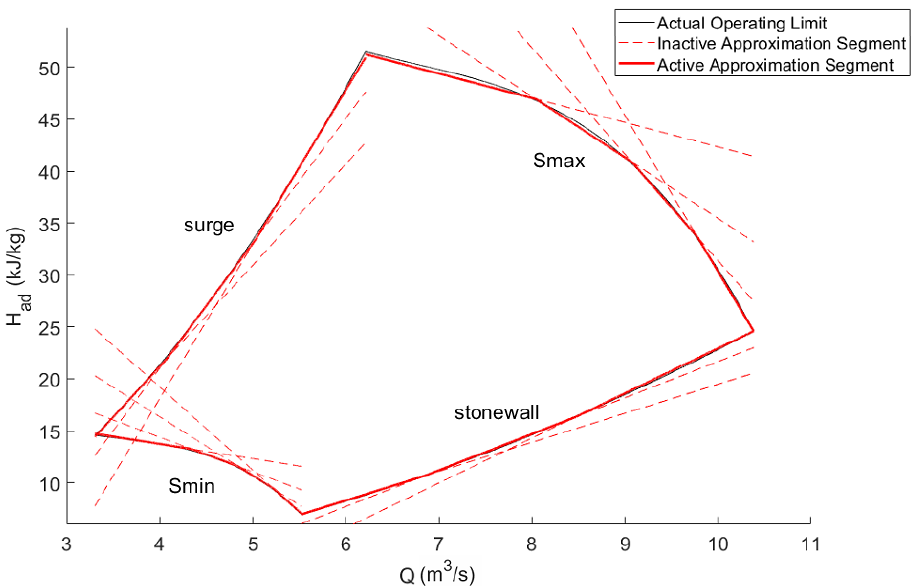
Figure 11. Approximation of the compressor operating envelop shown in Figure 4.